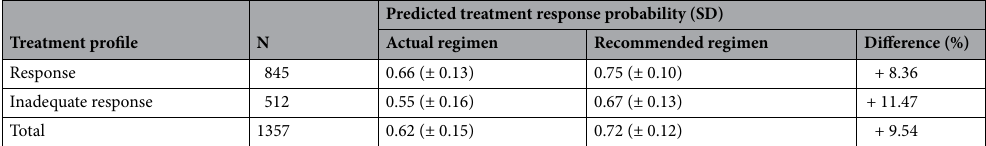
Table 5. Treatment response prediction of 1357 treatment profiles in the validation set, comparing average response probability of actual regimen and recommended